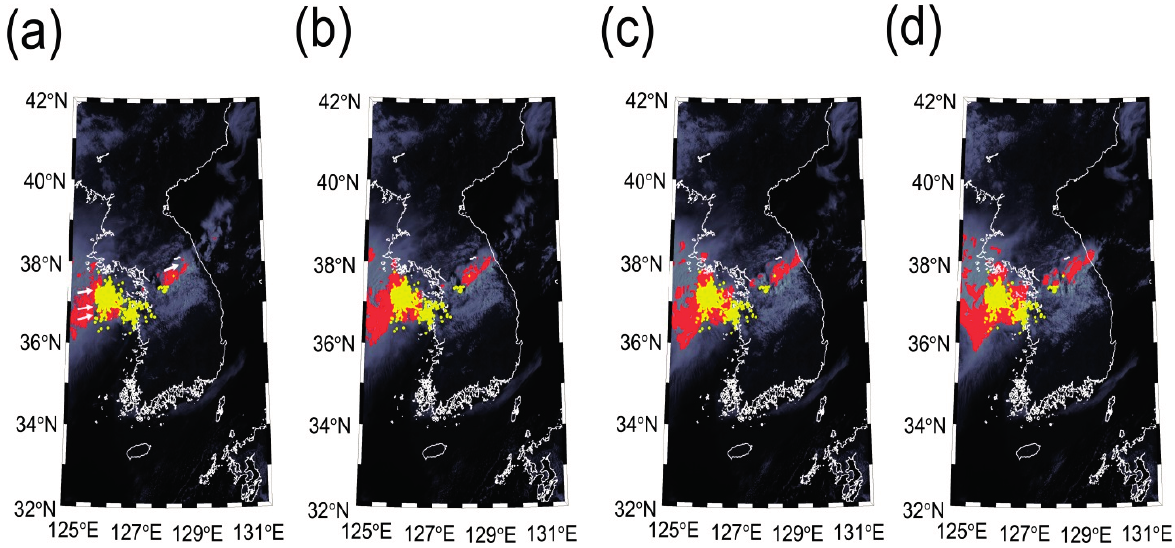
Figure 7. CI detection maps for the case in 2013 (CI by frontal cyclone) generated from the RF model, overlaid with COMS MI IR1 images obtained ( a ) 60 min, ( b ) 45 min, ( c ) 30 min, and ( d ) 15 min before the image acquisition at the nearest time of the lightning occurrence. Red objects are the predicted CI and yellow dots represent the location of lightning occurrences. White arrows in (a) represent the movement directions of cloud